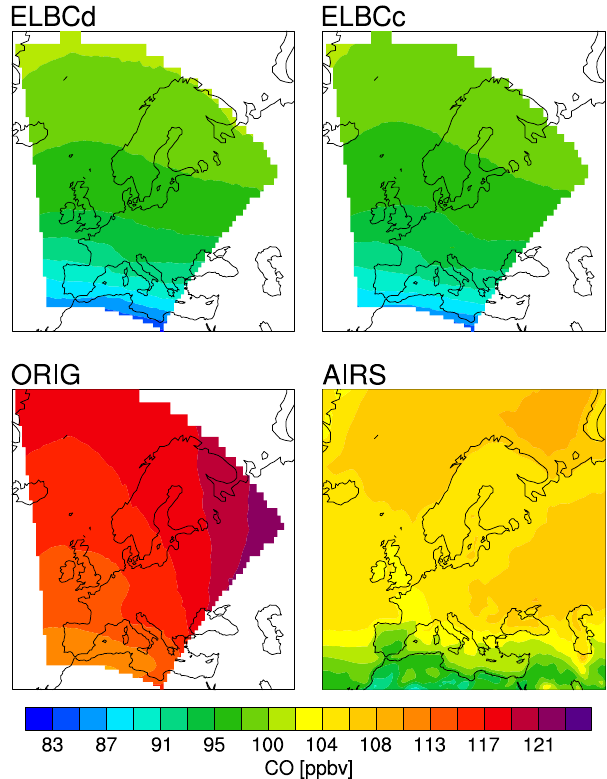
Figure 14. CO volume mixing ratios at 500hPa for the ELBCd (top left), ELBCc (top right), ORIG (lower left) and the AIRS (lower